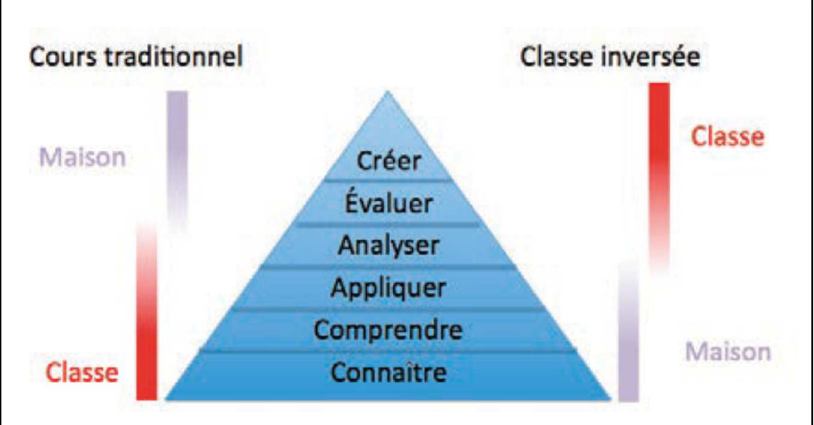
Fig. 11. Activités à la maison et activités en